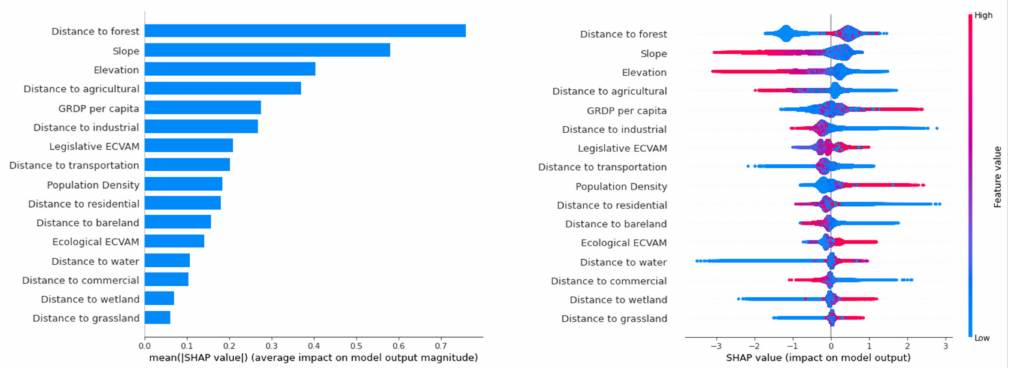
Figure 4. Factor importance (SHAP